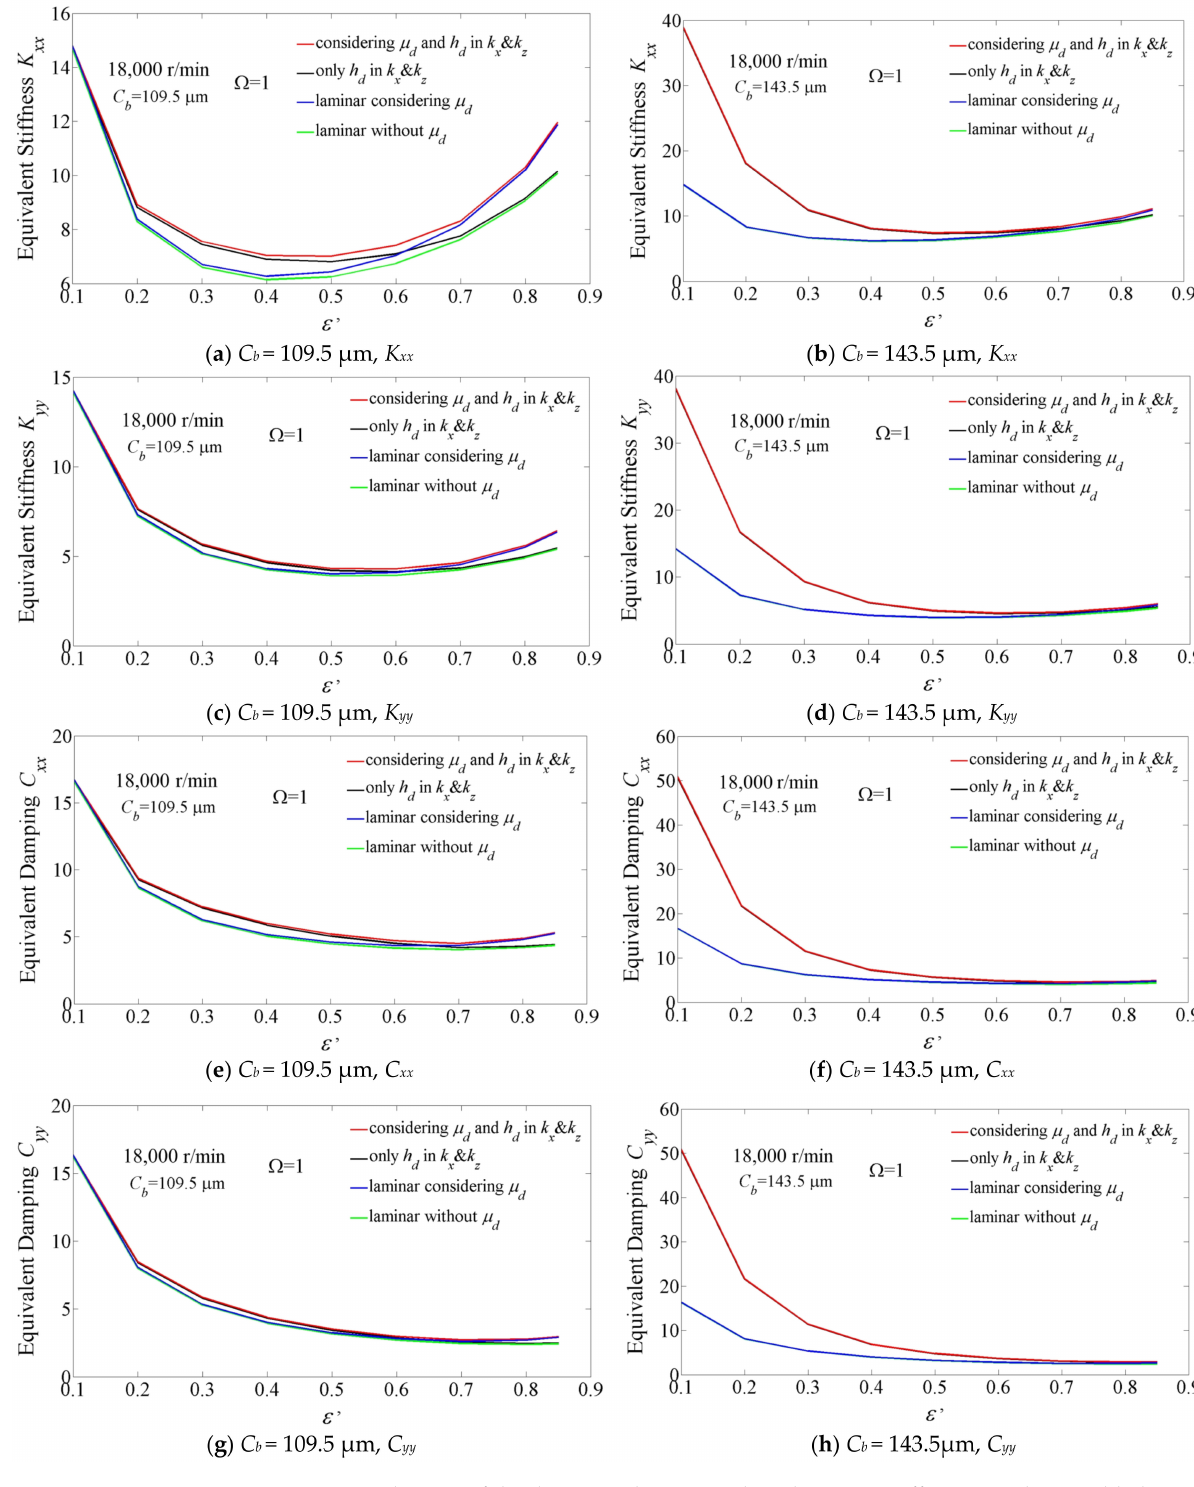
Figure 4. Changes of the dimensionless equivalent dynamic coefficients with assembled eccentricity ratio at different assembled